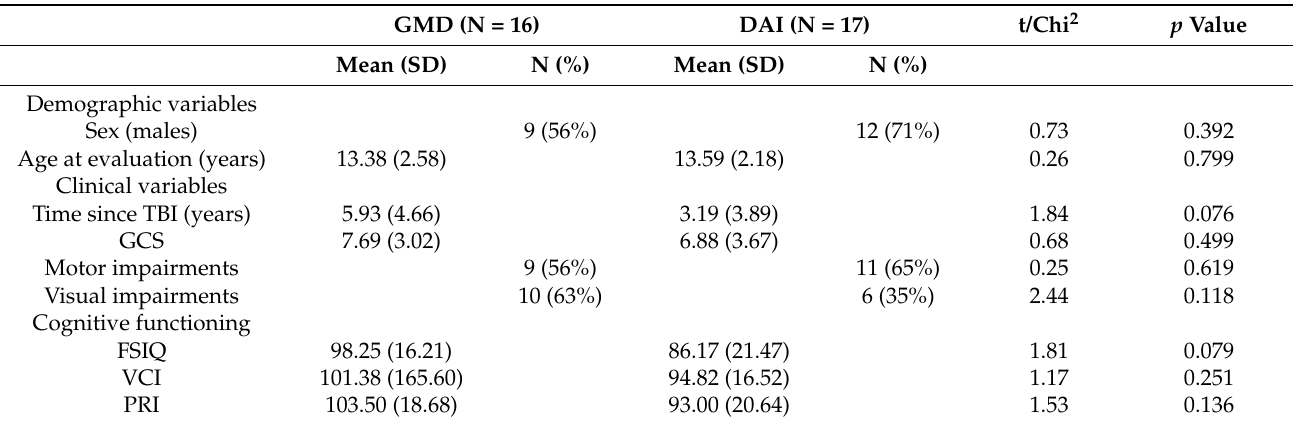
Table 1. Demographic and clinical variables of patients with grey matter damage (GMD) and diffuse axonal injury (DAI).